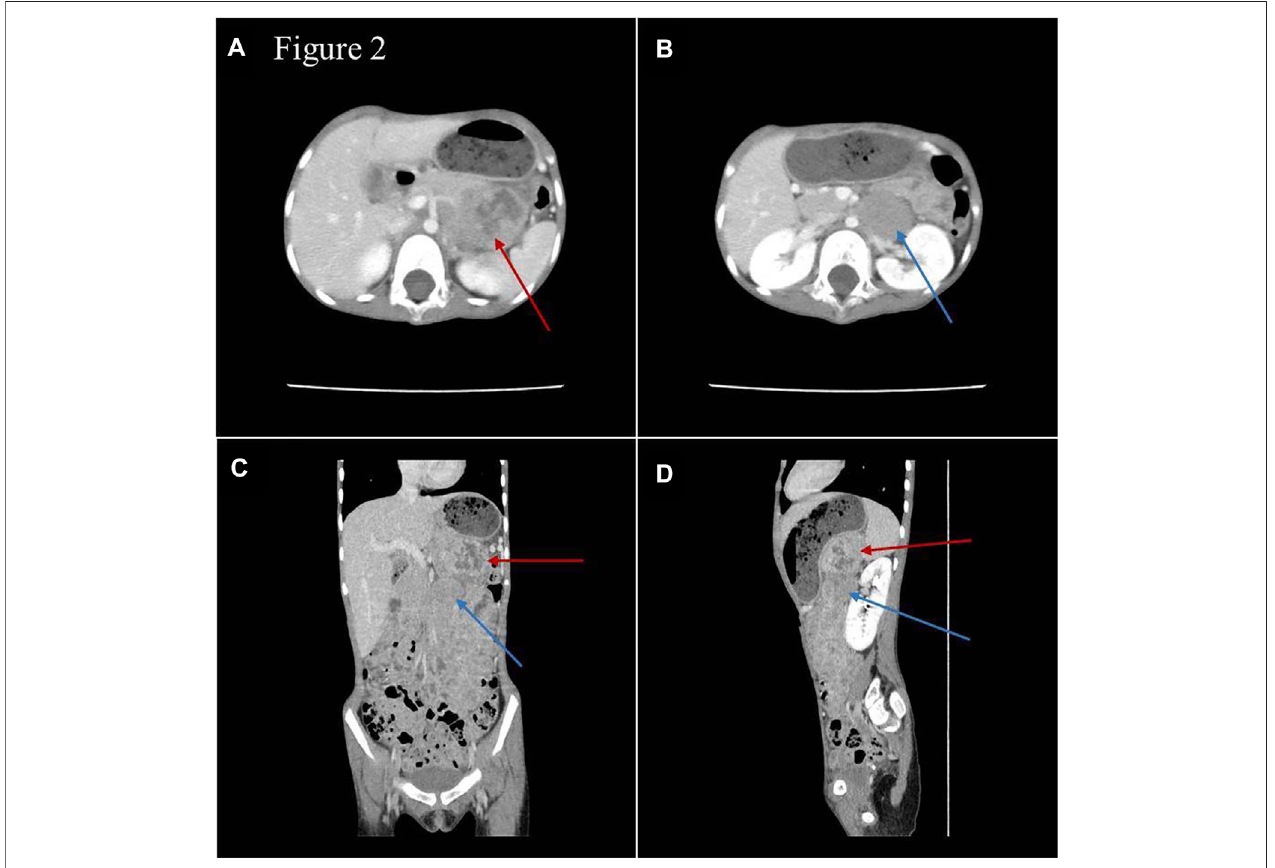
FIGURE 2 | Images of abdominal enhanced CT (A,B) and three-dimensional reconstruction (C,D) . Space-occupying lesions with inhomogeneous enhancement were in the body and tail of the pancreas (red arrow) and in front of the left renal vein (blue arrow), and the paraaortic lymph nodes were enlarged.